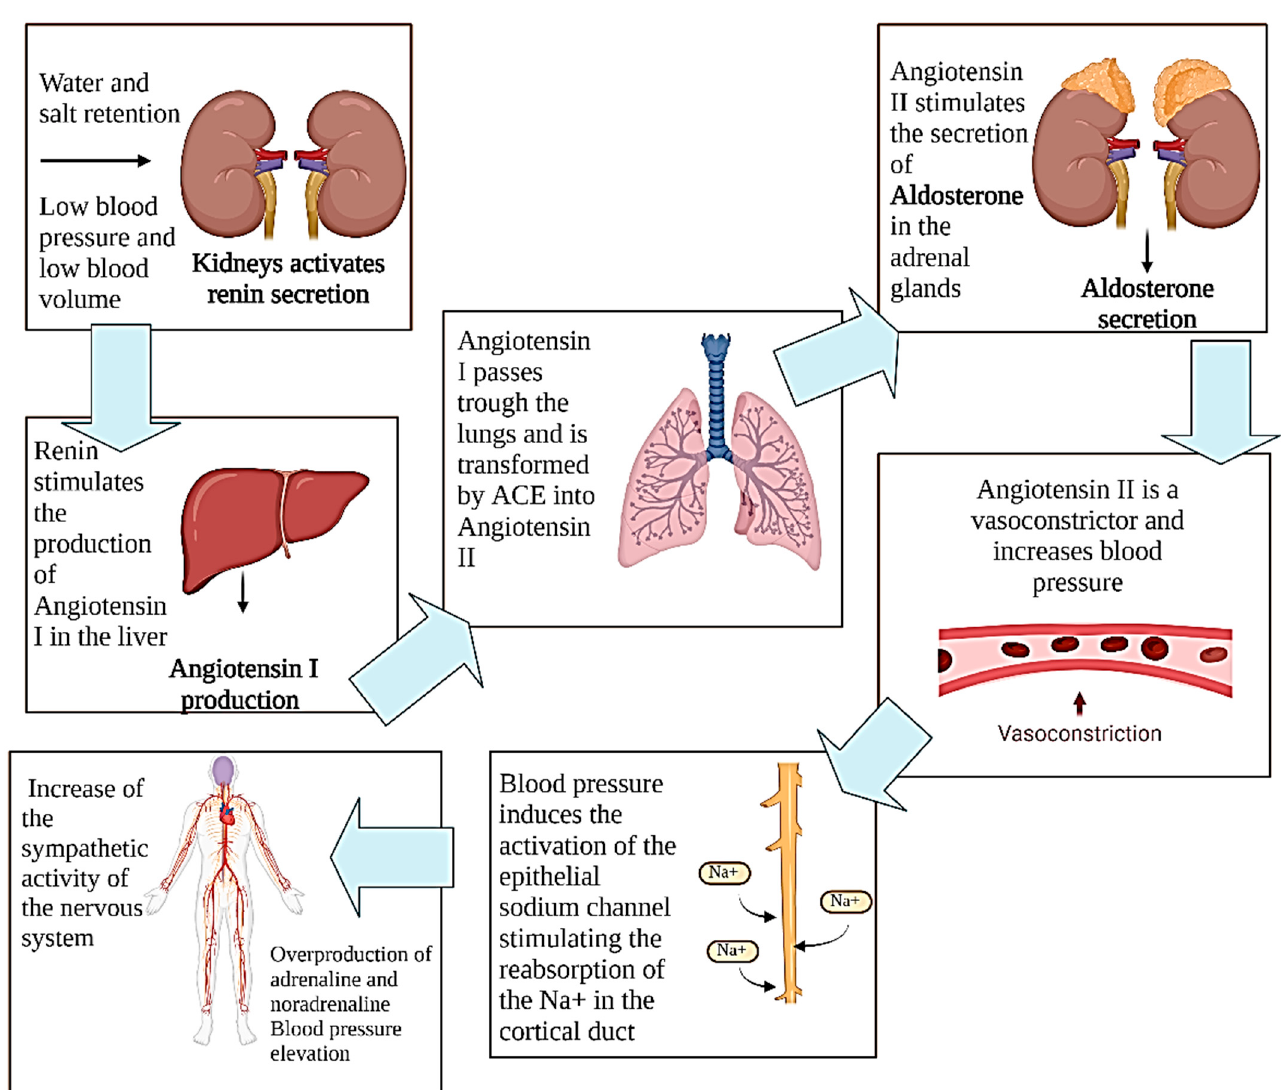
Figure 1. Renin–angiotensin–aldosterone system. Created with BioRender.com (accessed on 5 october 2022).